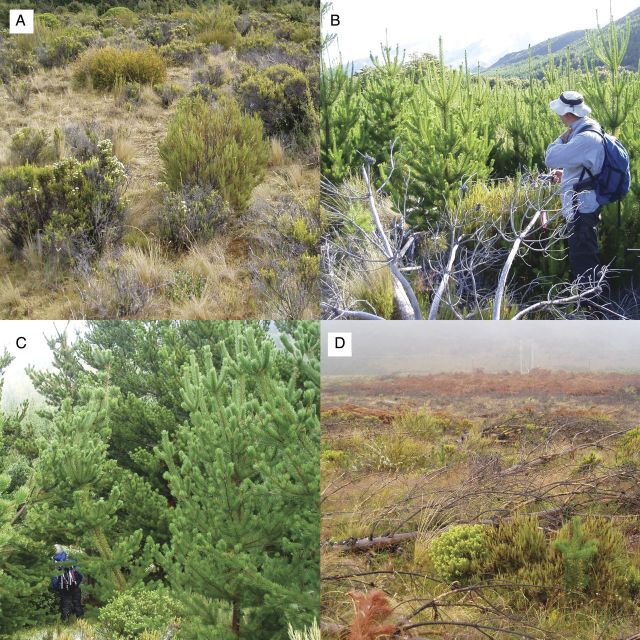
Examples of the four levels of invasive P. contorta management (A) Seedling-Removal, with dominance by native shrubs, herbs and grasses along with some invasive herbs, (B) Sapling-Removal, where the periodic removal of P. contorta has prevented closed-canopy formation (this photo taken 2 years after sampling was conducted), (C) No-Removal, with tall closed-canopy Pinus and (D) Tree-Removal, where closed-canopy Pinus was cut 3 years prior to this study.